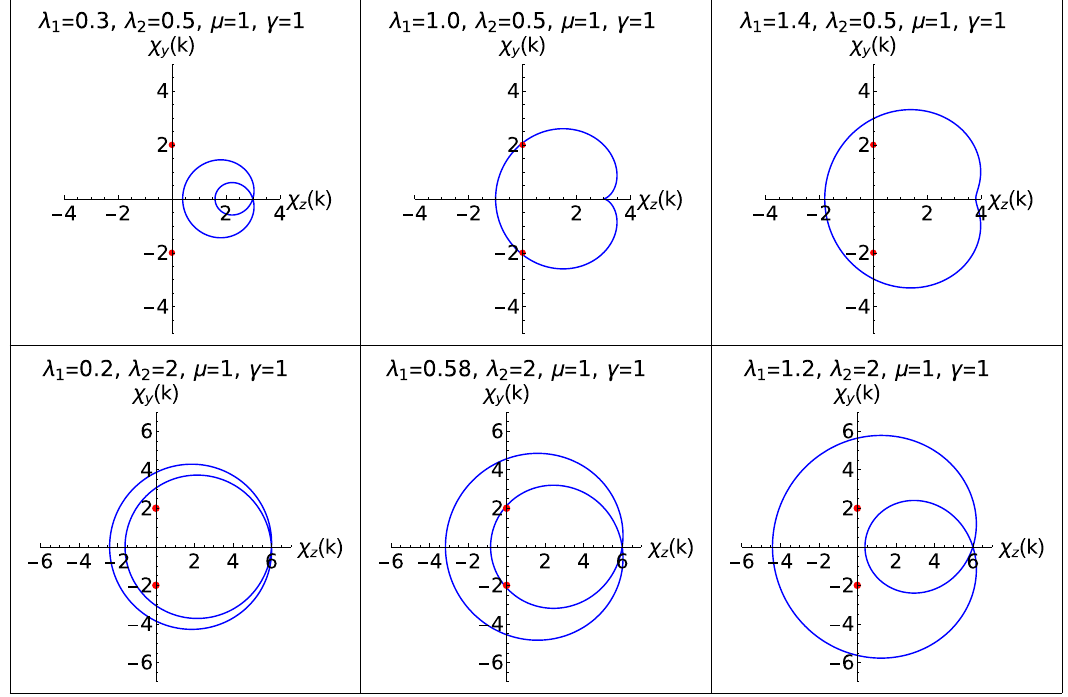
Figure 4. Parametric plots are represent the topological phase transitions in the positive (cid:31) 2 region. Upper and lower panel corresponds to W=1 and W = 2 to 1 respectively. Middle plot in both the panels represents the parametric curves at critical